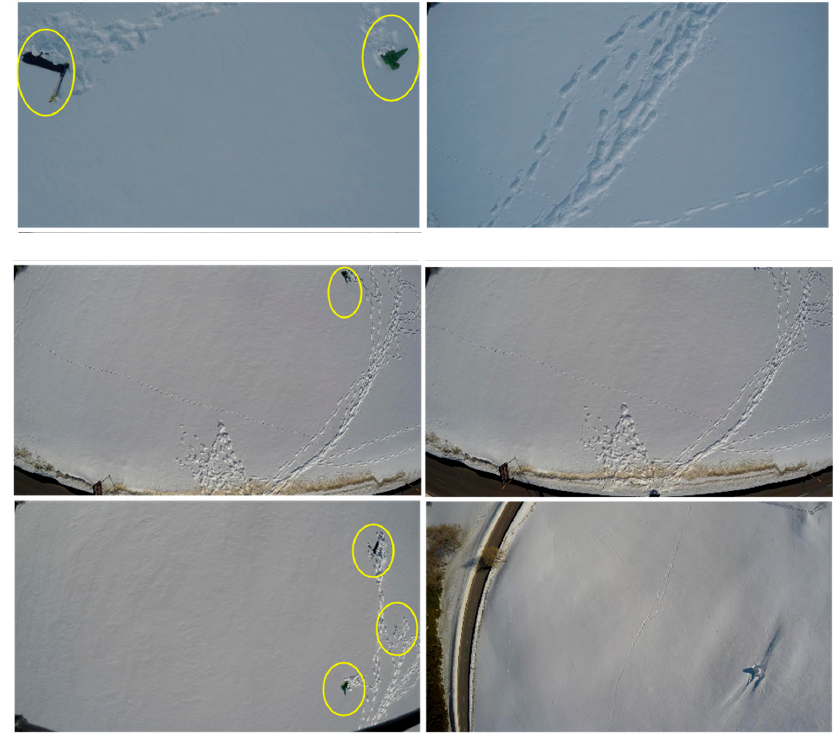
Figure 6 . Positive ( left ) and negative ( right ) frame snapshots from the second dataset. Objects of interest (skis, jacket to simulate bottom half-buried victim, and ski pole) are marked by yellow circles.